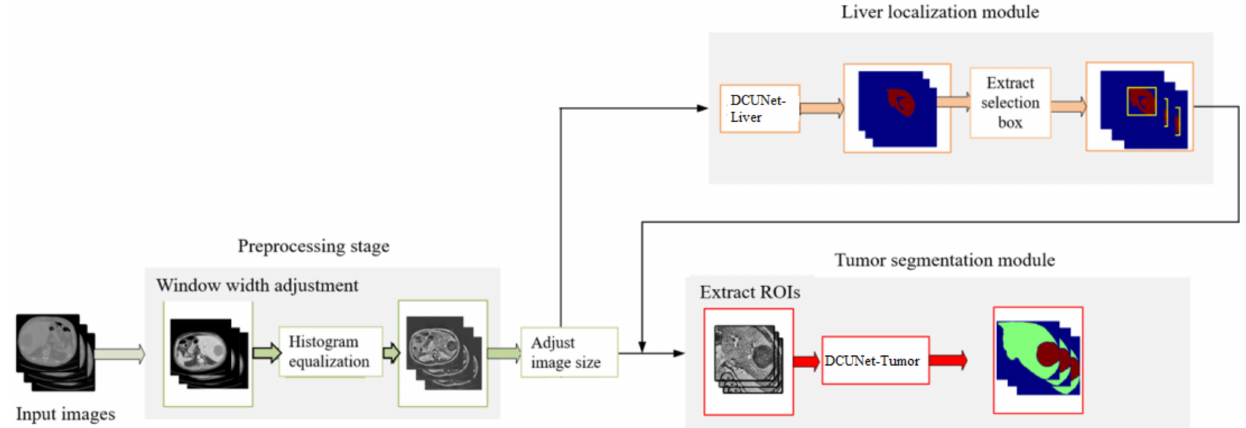
Figure 1. The overall flowchart of the algorithm.